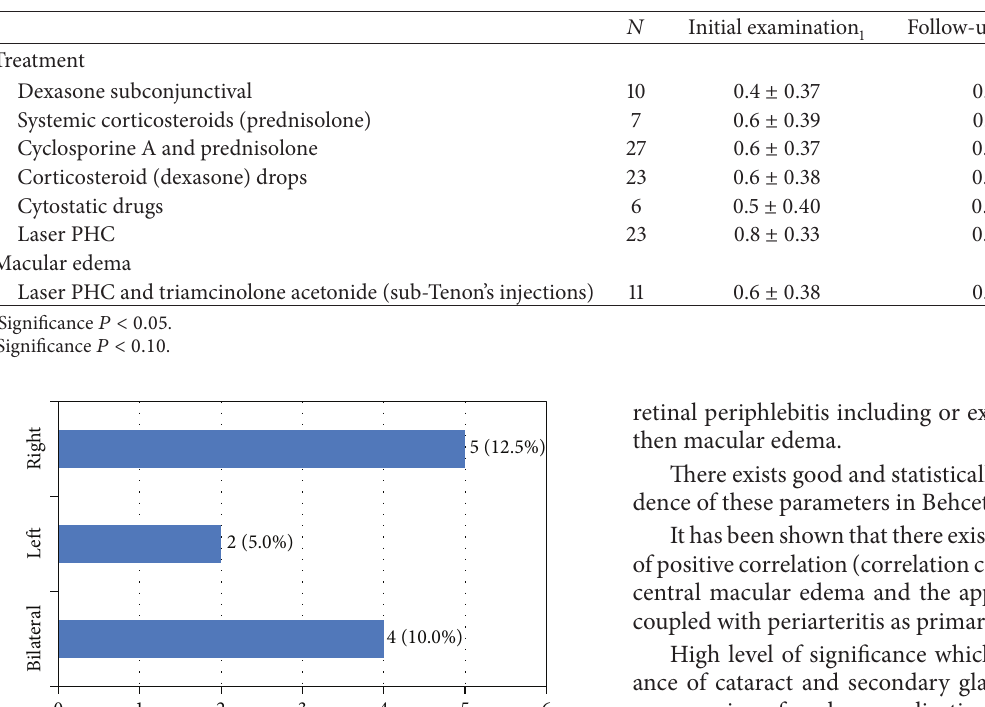
Table 4: Behcet’s disease, average visual acuity efficiency coefficient dependent on treatment and presence of macular edema.